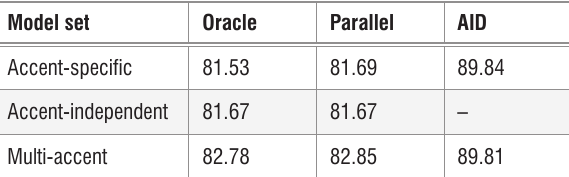
Recognition performance of the oracle and parallel